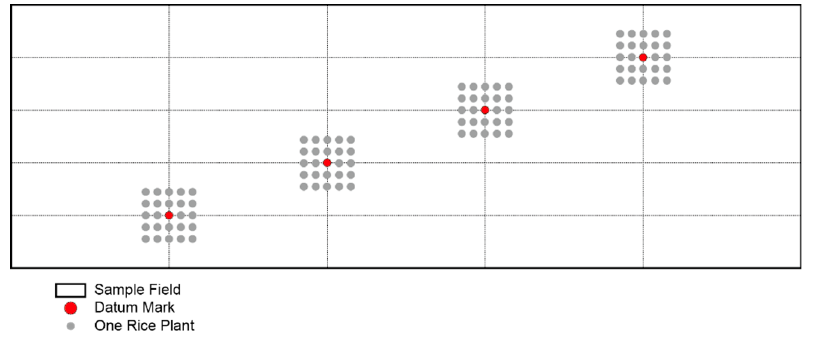
Figure 2. Schematic of ground survey data collection method commonly used in Taiwan.